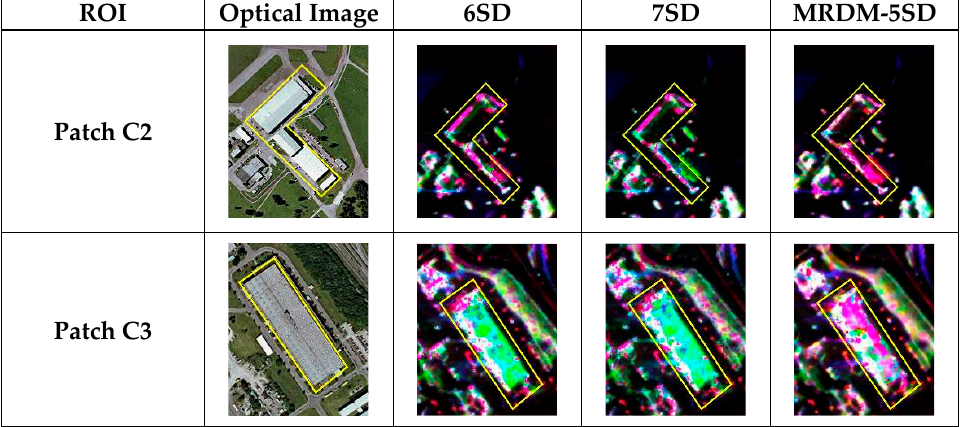
Figure 16. Enlarged view of Patch C2 and C3 (both highly oriented buildings) via 6SD, 7SD and MRDM-5SD (RGB component: red: double-bounce scattering, green: volume scattering, blue: surface scattering).